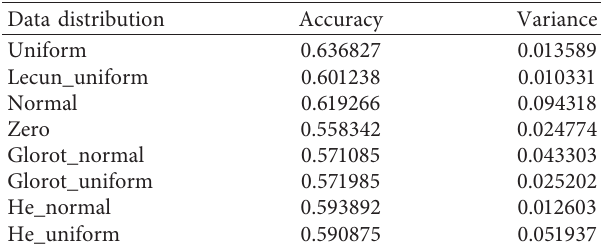
Figure 2: Spectral entropy fluctuates greatly with changes in energy level. Table 3: The influence of different initialization weight vectors on Table 2: The influence of different energy fluctuation forms on the the accuracy of emotion recognition. accuracy of emotion recognition.